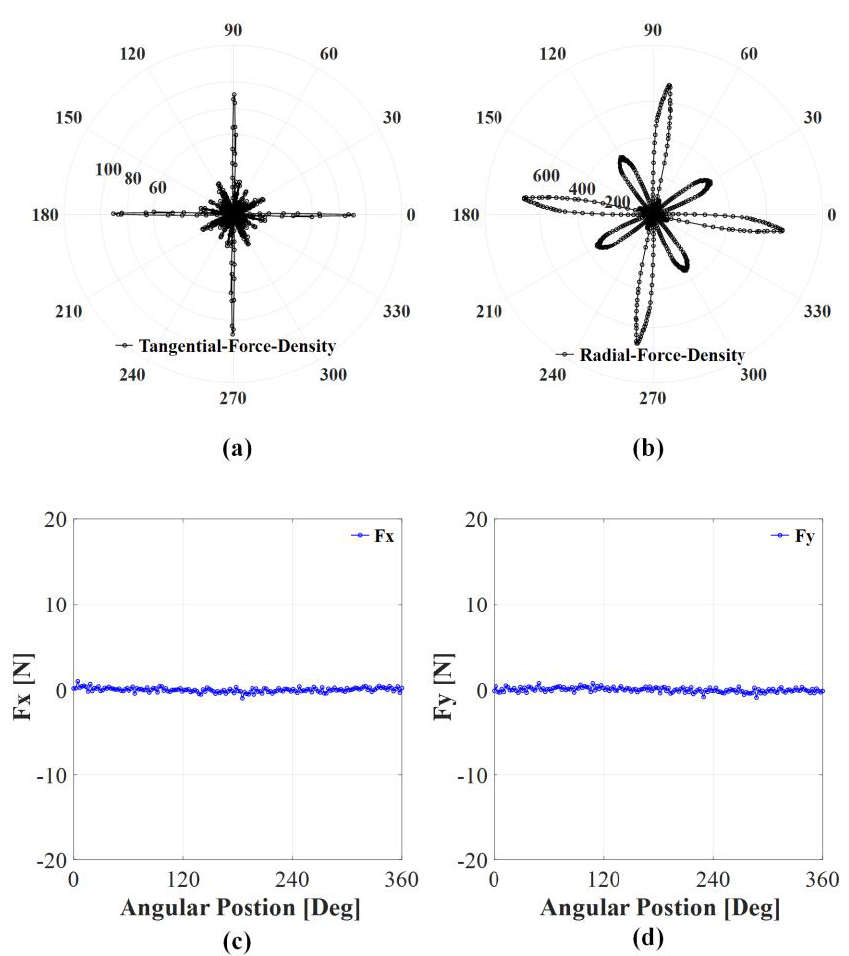
Figure 8. Force density and UMF result: ( a ) tangential distribution, ( b ) radial distribution, ( c ) x- component, and ( d ) component, and ( d ) y-component.